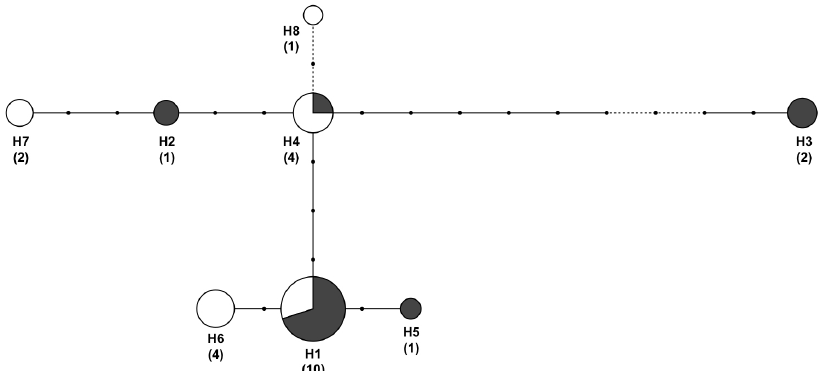
Figure 2. Median-joining network showing relationships between haplotypes (constructed using NETWORK 4.2.0.1). The Haplotypes are represented by circles with sizes proportional to respective frequency and absolute frequencies are indicated by number in parentheses. The mutation steps between the haplotypes are represented by small black dots along the lines. The branch lengths are proportional to the number of mutational steps separating haplotypes. All sites were treated with equal weights. Indels were included in the network analysis (and are represented by dashed lines). Note that if indels were not taken into account, haplotype h8 would be identical to haplotype h4 and haplotype h3 would be separated by one less mutation step from h4. The proportion of haplotypes found in both regions are indicated by different colours: black for Cufada Lagoons Natural Park (CLNP) and white for Cantanhez Forest National Park